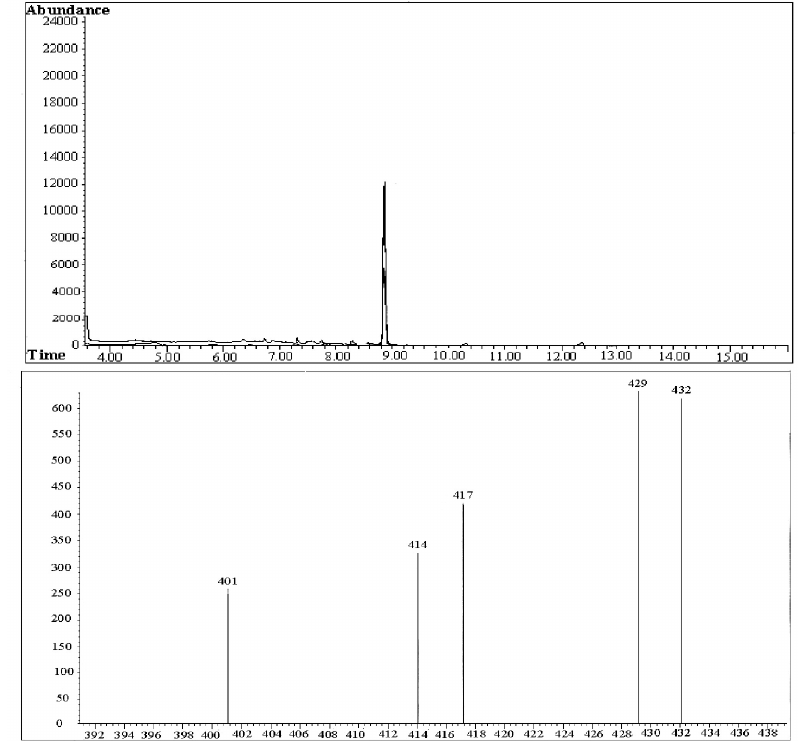
Figure 1. Determination of plasma morphine concentration through CG-MS. Chromatograms: morphine and morphine - D3 (internal standard 250ng) 8.8 minutes. Run 16 minutes. Mass spectrum: mass 429 (morphine); mass 432 (morphine